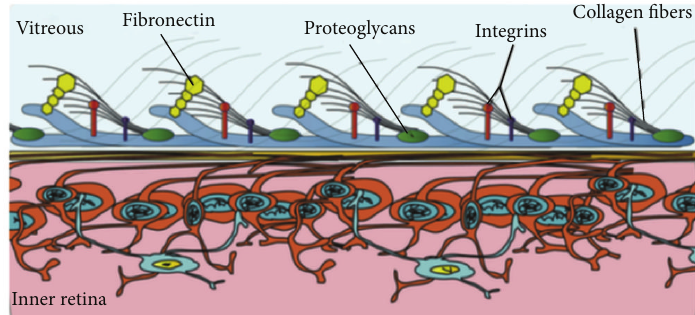
Figure 1: Vitreoretinal attachments at the vitreoretinal interface. Source: